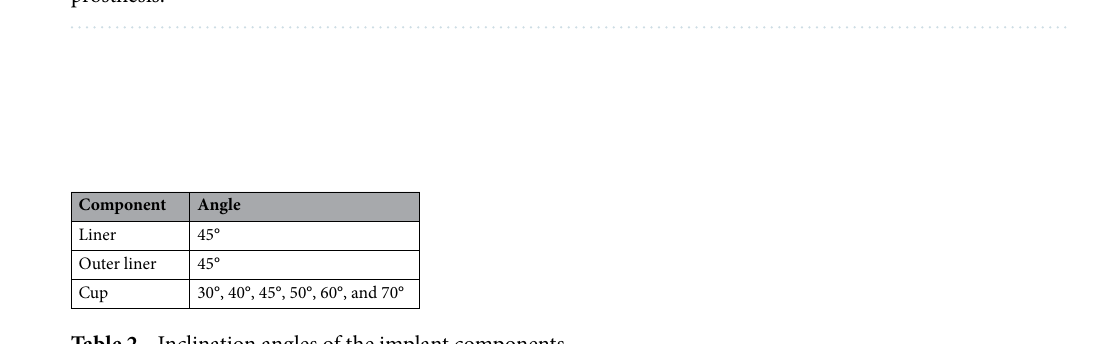
Figure 2. Variations in inclination angle on the acetabular cup component of the new dual-mobility hip joint prosthesis.